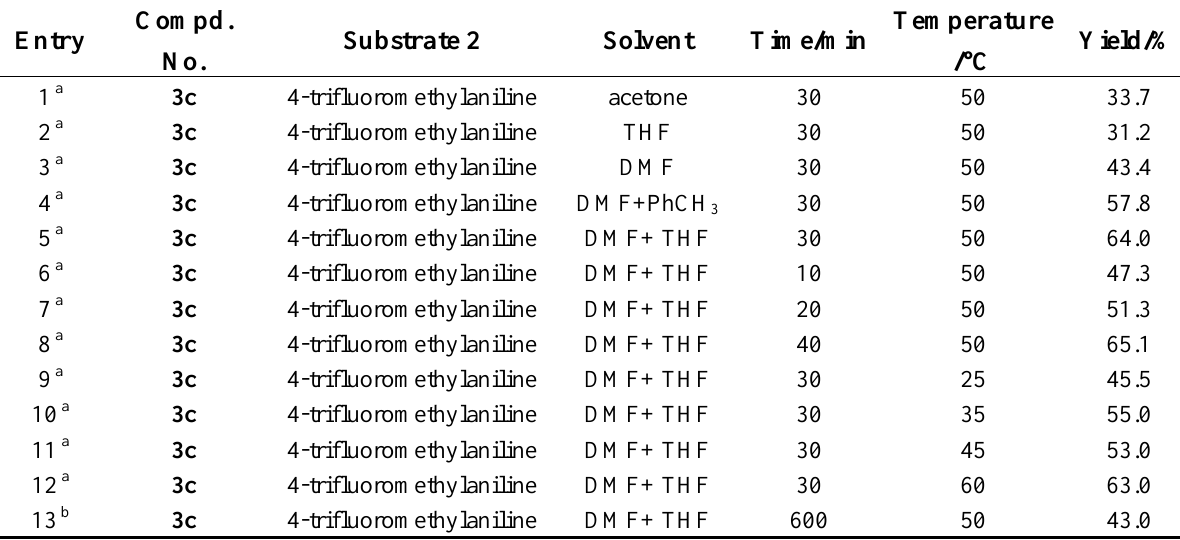
Table 1 . Synthesis of 3c under different reaction conditions and microwave irradiation.